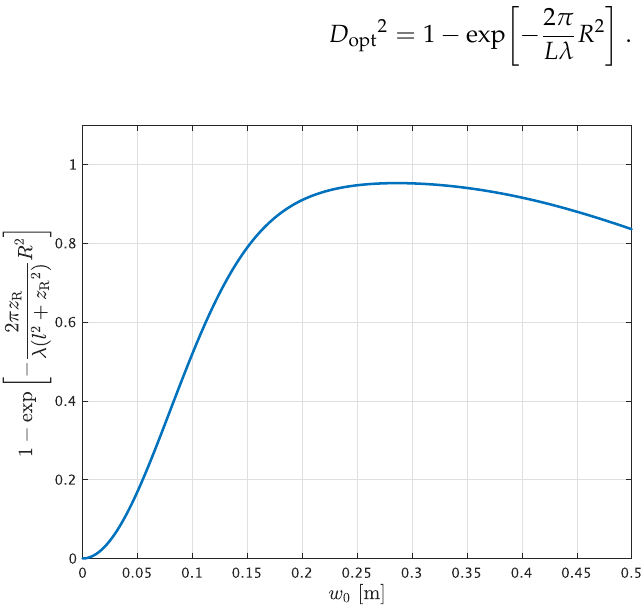
Figure 6. Dependence of D 2 on w 0 with the default DECIGO parameters. There is a maximum D 2 for specific beam waist w 0